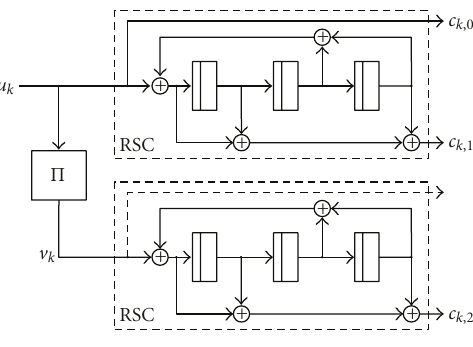
Figure 1: 3GPP-LTE turbo